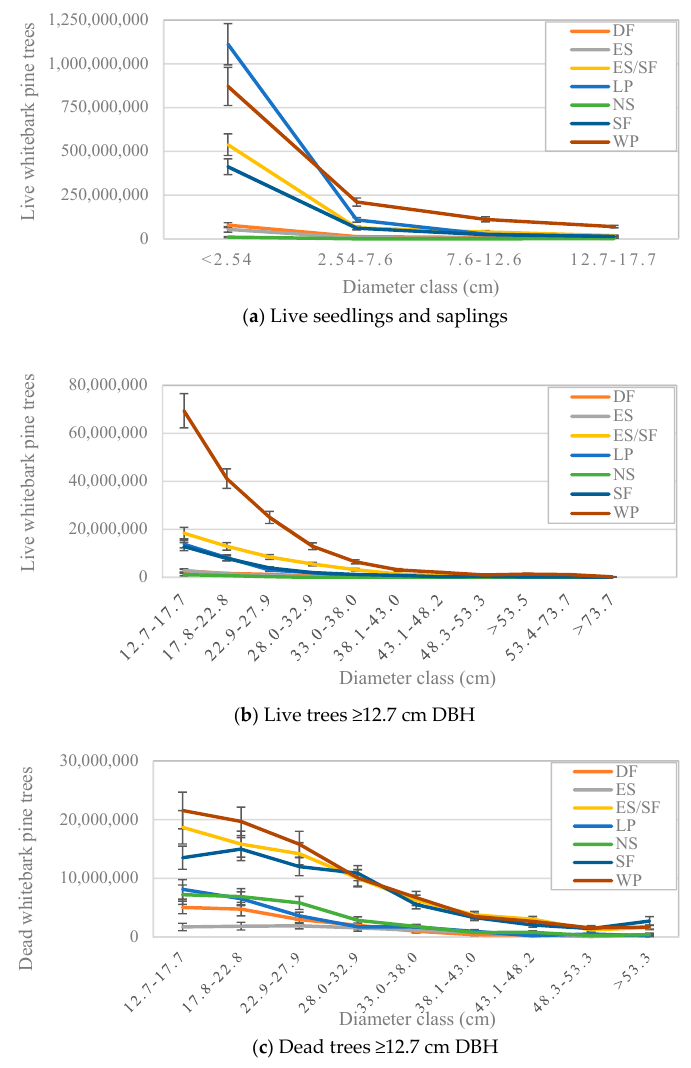
Figure 4. Population estimates of the numbers of ( a ) live whitebark pine seedlings and saplings ( n = 1142 plots), ( b ) live whitebark pine trees ( n = 1142 plots), and ( c ) dead whitebark pine trees ( n = 1078 plots) in the western US in major forest types, by diameter class. Forest types are abbreviated: WP = whitebark pine, LP = lodgepole pine, ES/SF = Engelmann spruce/subalpine fir, SF = subalpine fir, DF = Douglas-fir, ES = Engelmann spruce, and NS = nonstocked. Forest type symbols are the same in all the panels; y axes are scaled differently in each panel. The forest types shown here account for more than 98% of all whitebark pine trees in each of the following categories: dead trees at least 12.54 cm DBH., live trees at least 2.54 cm DBH., and live seedlings at least 15.24 cm tall. Error bars represent +/ − one standard error [20]. Note that the number of plots used for live vs. dead tree estimates differ due to spatial–temporal differences in sampling protocols for dead trees; population-wide estimates account for these differences